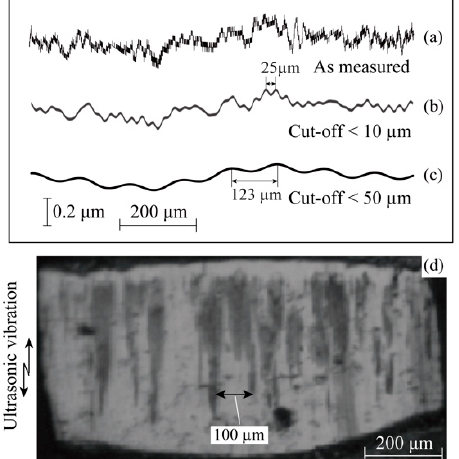
Figure 5. Comparison between surface roughness and video capture at t = 100 ms. The surface roughness is that of the Al ribbon surface, measured in the width-direction of Al ribbon: ( a ) As measured surface roughness; ( b ) Surface profile after cutting off wavelength less than 10 µm; ( c ) After cutting off wavelength less than 50 µm; ( d ) Video capture at t = 100 ms under F b = 7 N and P u = 3 W.